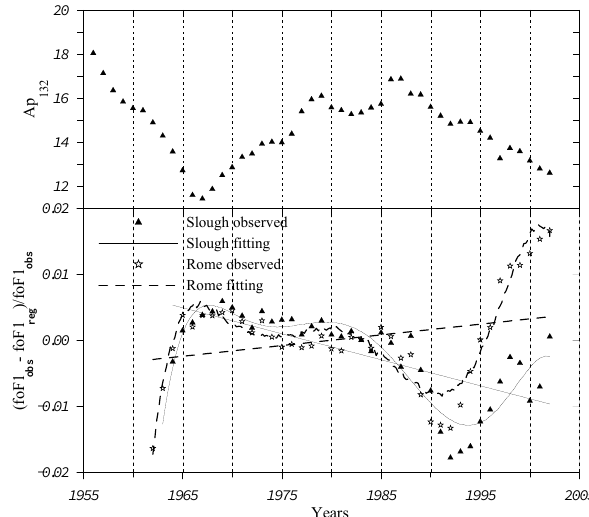
Figure 1 Fig. 1. 11-year running mean A p index, A p 132 (top panel) and δ fo F1 132 (bottom panel) long-term variations at noon for Slough/Chilton and Rome stations. Polynomial approximations of the observed δ fo F1 132 variations are given for the obviousness as well as linear trends obtained over the whole